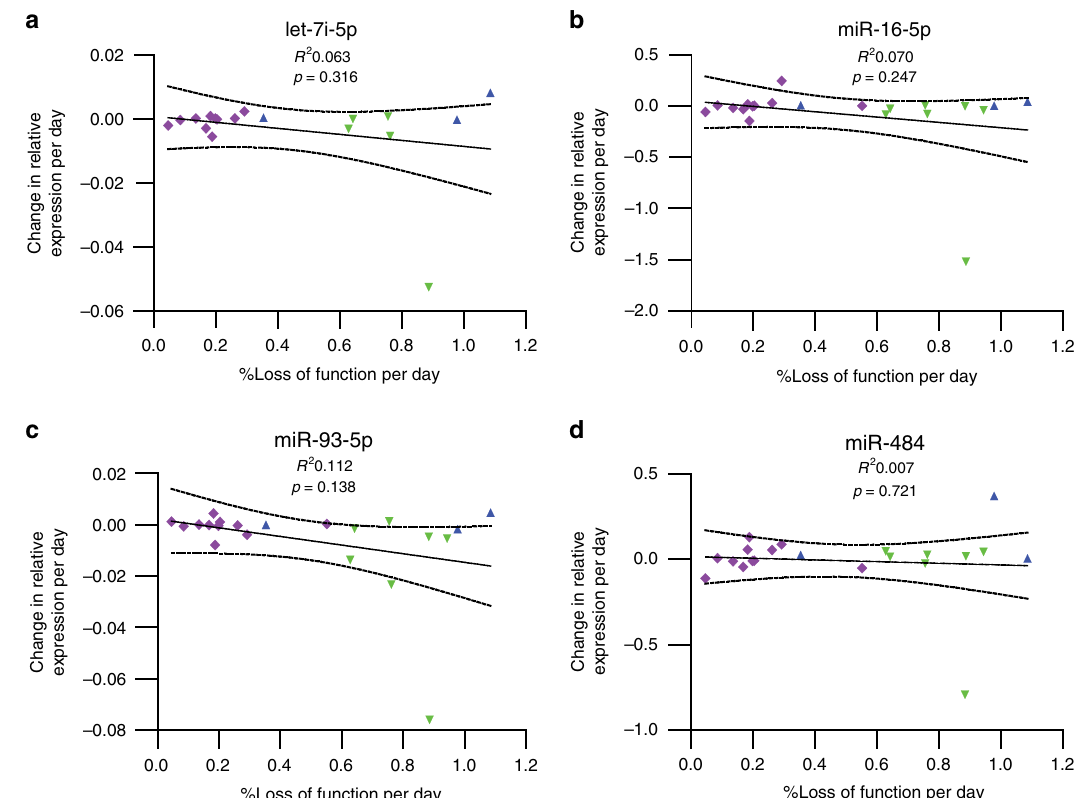
Fig. 4 Disease progression and change in miRNA levels in longitudinal samples. miRNA expression was measured relative to the control small RNA RNU6-2 for ( a ) hsa-let-7i-5p, ( b ) hsa-miR-16-5p, ( c ) hsa-miR-93-5p and ( d ) hsa-miR-484. hsa-miR-484 is a non-DE miRNA shown here for comparison. %Loss of function per day was calculated from decline in MRC Scale score. Linear regression R 2 and p -values are shown. Dotted lines represent 95% con fi dence intervals. Data points are coded by PRNP codon 129 genotype (MM blue triangles, MV magenta diamonds, VV green inverted triangles). n = 21 individuals (18 for let-7i-5p). Source data for ( a – d ) are provided as a Source Data fi